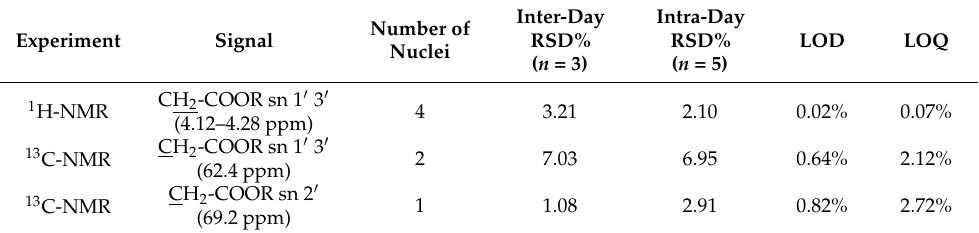
Table 1. Inter- and intra-day precision results, and the LOD and LOQ values were calculated on corn glycerol backbone signals. The precision results are expressed as percent relative standard deviations (RSD%), LOD and LOQ are expressed as percentages (% w/w ).